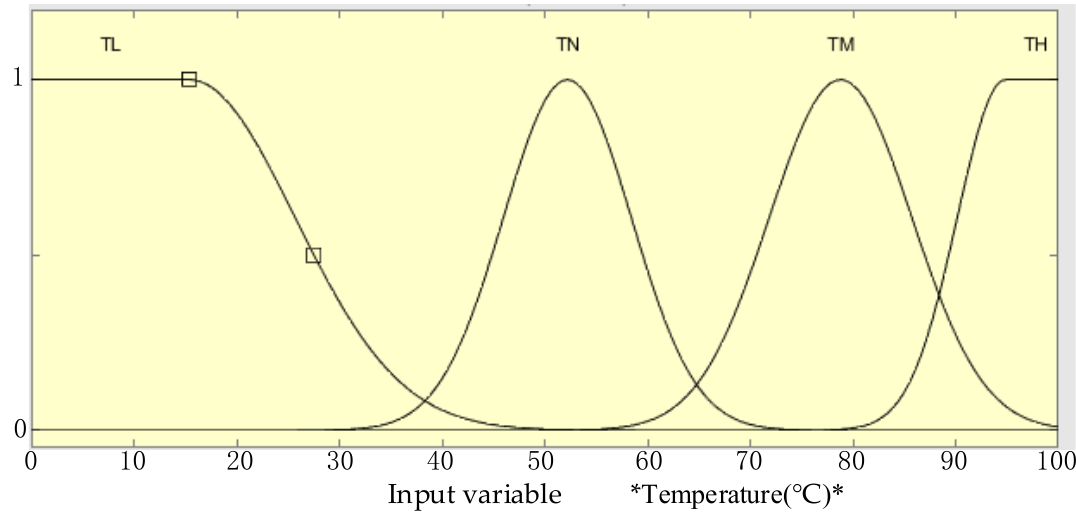
Figure 10. Graph of temperature membership function.